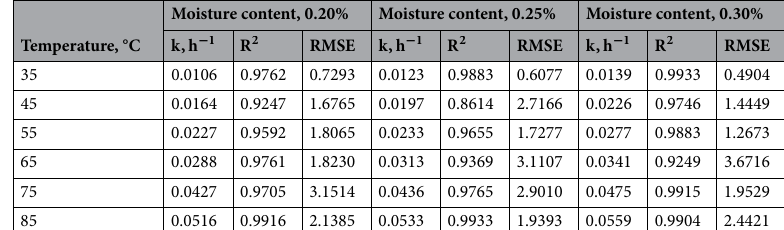
Moisture content, 0.20% Moisture content, 0.25% Moisture content, 0.30% k,h − 1 R 2 RMSE k,h − 1 R Temperature, °C